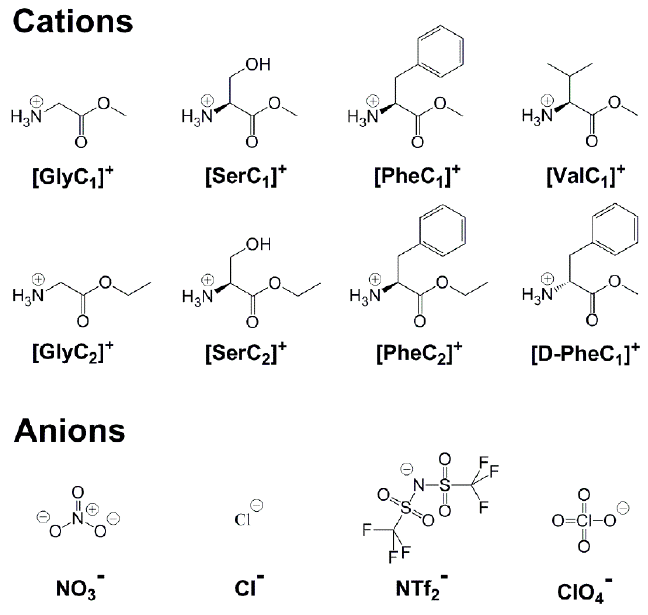
Figure 3. Structures and abbreviations of the [AAE]X cations and anions.